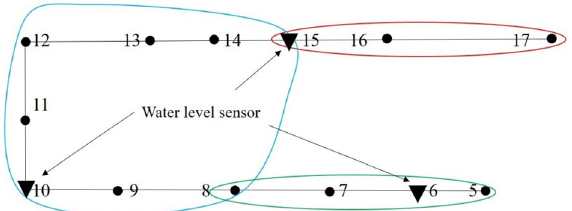
Figure 6. The result of the greedy algorithm (node 10, 6, and 15).